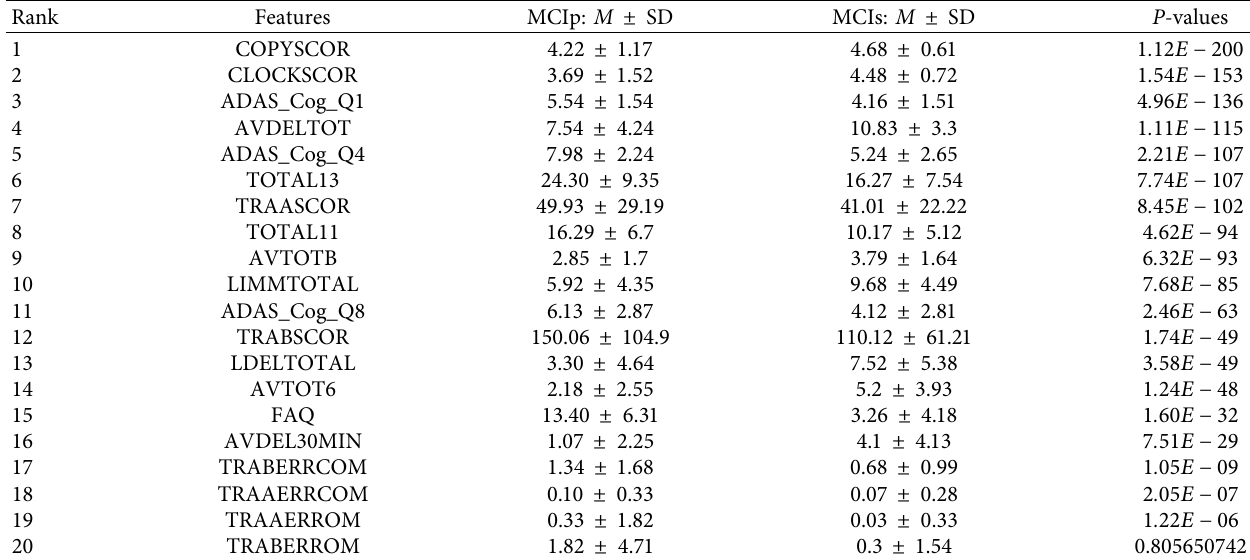
Table 3: Neuropsychological measures ranking based on P